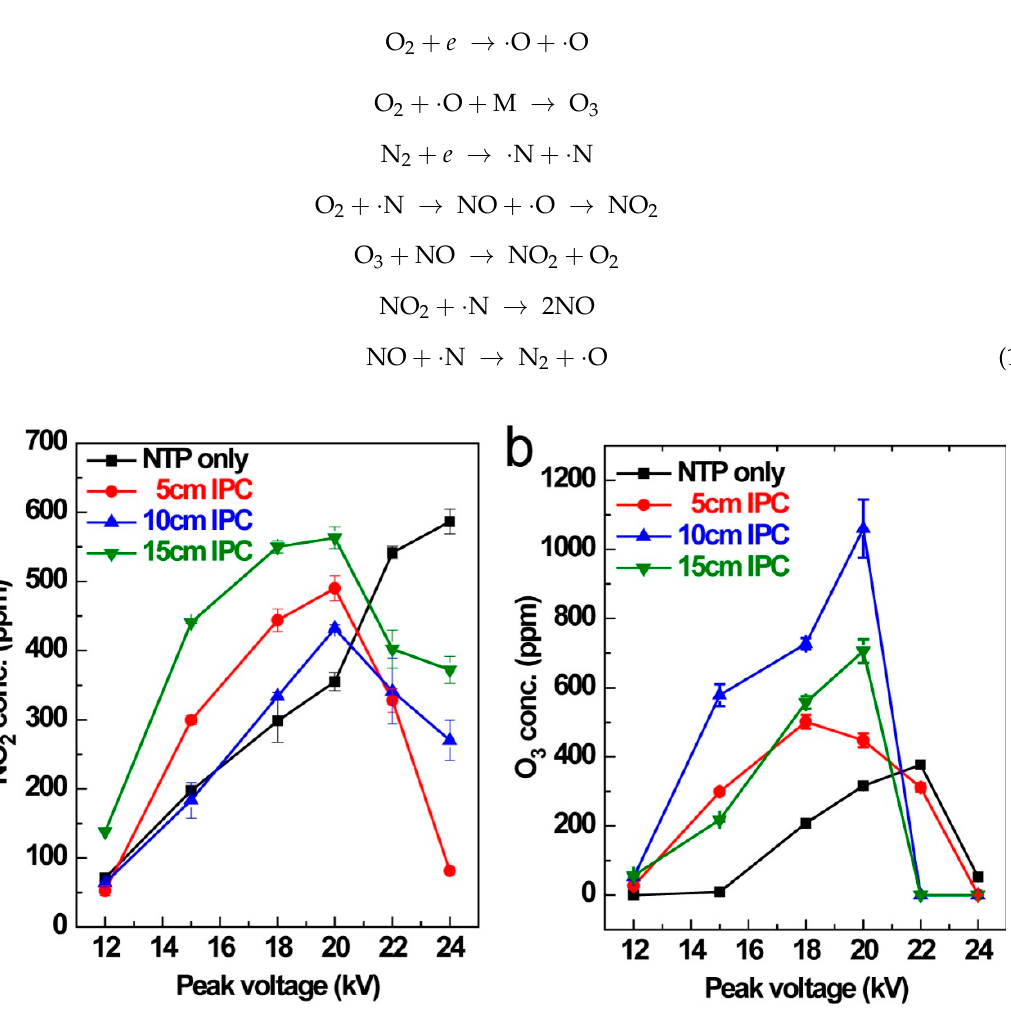
Figure 5. NO 2 ( a ) and O 3 ( b ) production under different catalyst loading and input peak voltage. (IPC length = 15 cm, RH = 0%, toluene initial concentration = 1000 ppm, flux = 400 mL/min, ambient temperature = 25 °C).